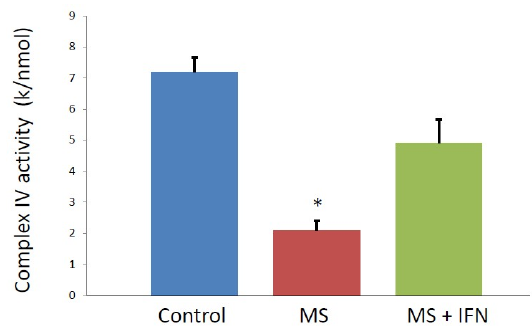
Figure 1. Blood mononuclear cell Complex IV activity, expressed as a ratio to citrate synthase, in control individuals, MS patients and MS patients receiving β-interferon (IFN). * Statistically different from both control and MS patients receiving β-interferon.